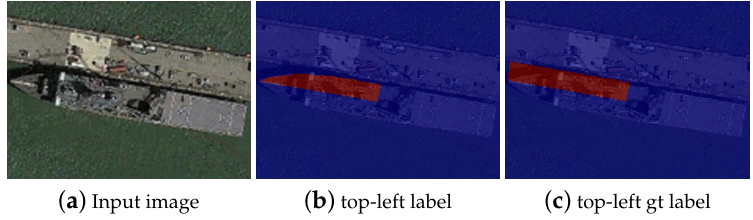
Figure 4. For the input image ( a ), taking ( b ) as the top-left part segmentation label would result in time-consuming annotation process. To avoid this problem, as shown in ( c ), we propose to use ground-truth box of the ship to generate ground-truth (gt) segmentation